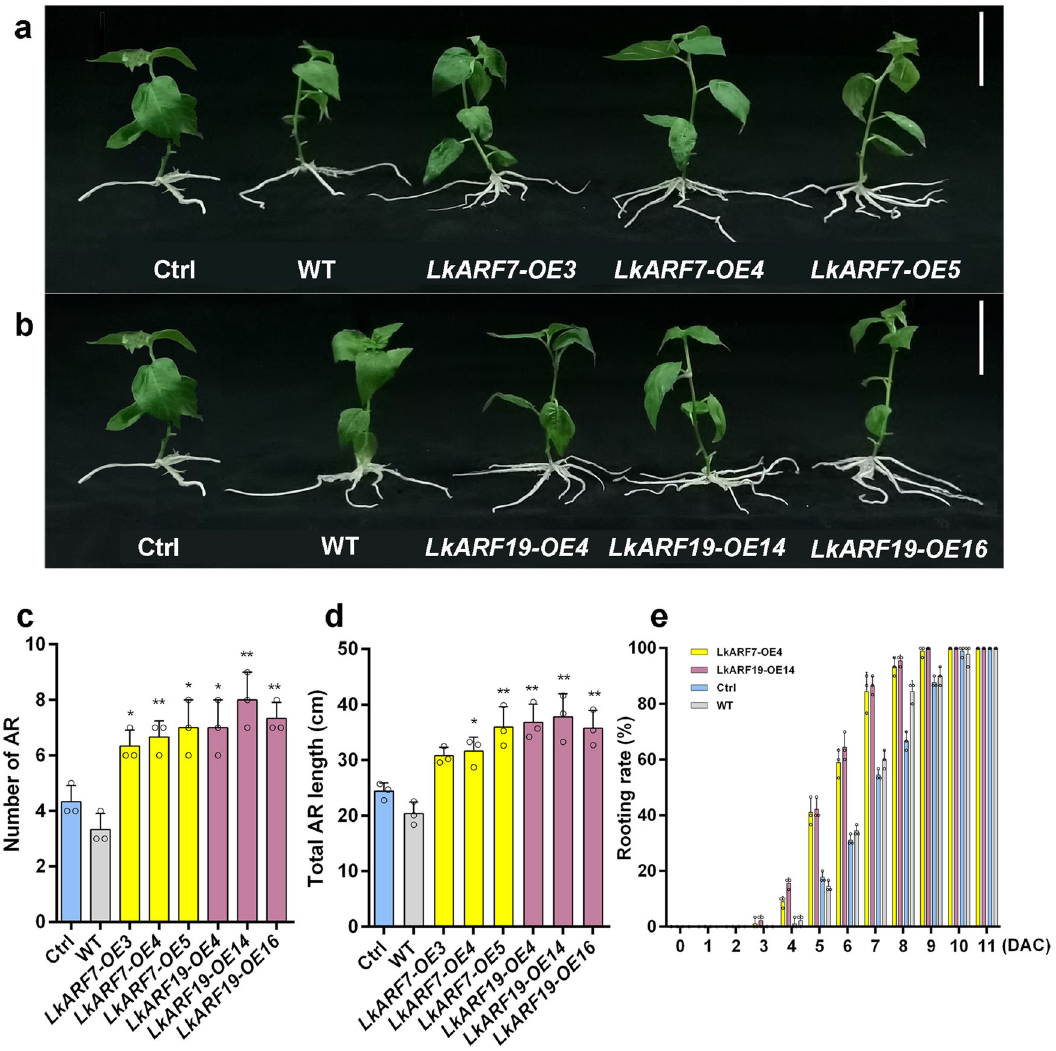
Fig. 3 Overexpression of LkARF7 and LkARF19 promoted AR formation in 84 K poplar. a , b AR phenotypes on 3-week-old control plants (Ctrl, transformed with empty vector), wild-type (WT), LkARF7 -OE, and LkARF19 -OE lines. Scale bars, 5 cm. c , d Average AR number ( c ) and total AR length ( d ) in the control plants and overexpression lines of 3-week-old seedlings. e Rooting rate of the control plants, WT, and overexpression lines within 11 days following cutting ( n = 30 per line). DAC, days after cutting. Error bars represent standard deviations from three biological replicates; * P < 0.05 and ** P < 0.01, t